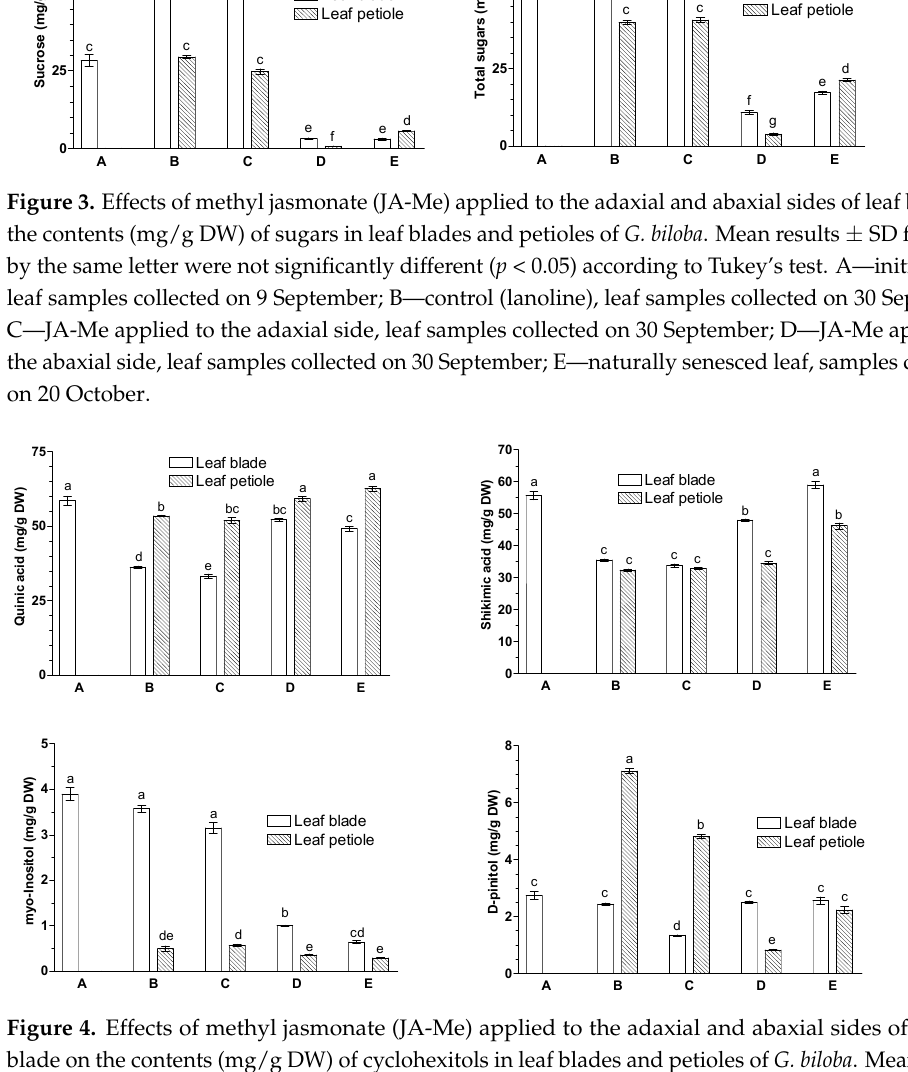
petioles, respectively, and this correlation was highly significant (<0.001). 2.4. Principal Component Analysis Principal component analysis (PCA) analysis applied to the entire metabolome dataset (normalized data) showed overall variation in the metabolite levels relative to the